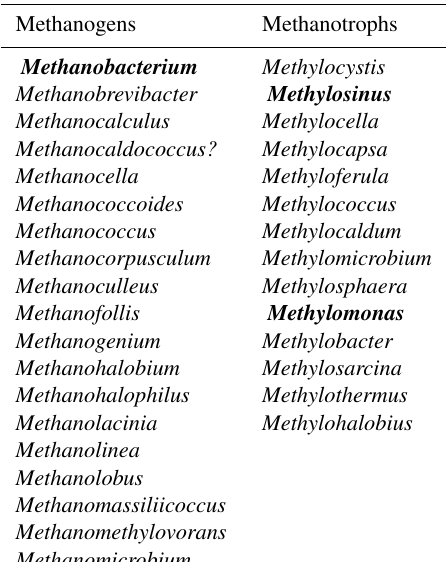
Table A1. Subset of amplicon-based lineages identified as genera of known methanogens and methanotrophs The genera found in the study are shown in bold